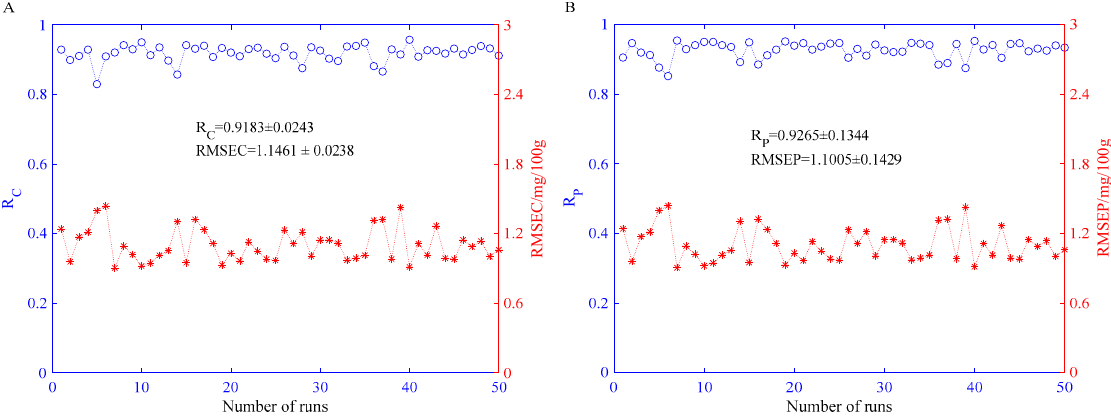
Figure 7. The statistical results of the BPNN models constructed on the fusion eigenvector. ( A ) Training set and ( B ) prediction set.